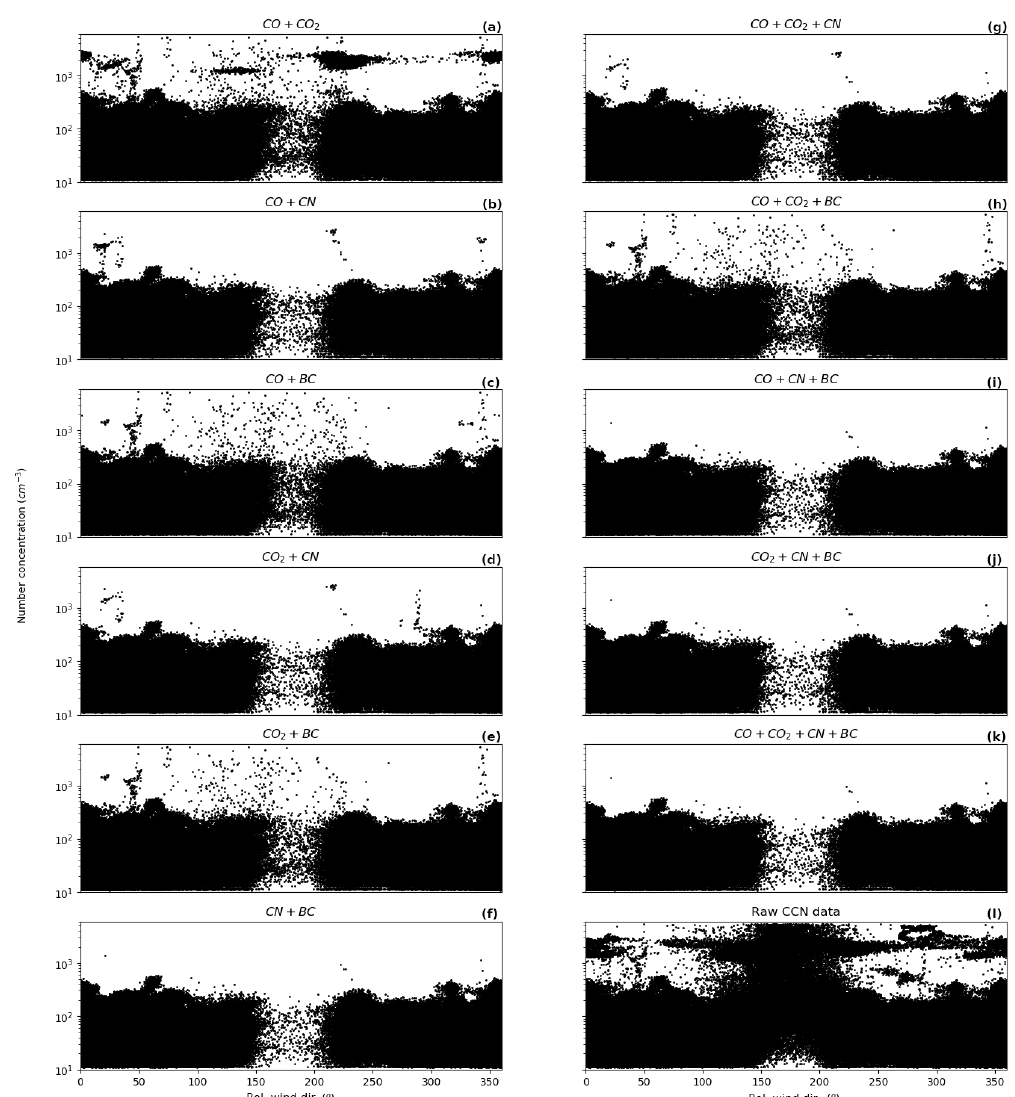
Figure A9. CCN data (log scale) with the different combinations of the algorithm applied separately: panels (a) – (f) show all two-parameter combinations, panels (g) – (j) show three-parameter combinations, panel (k) shows the filter using all four parameters and panel (l) shows unfiltered data for comparison. Note that the window filter is not applied to any of these